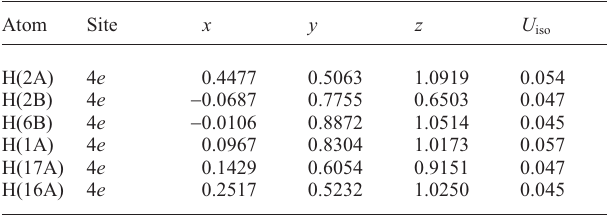
Table 2. Atomic coordinates and displacement parameters (in Å 2 )